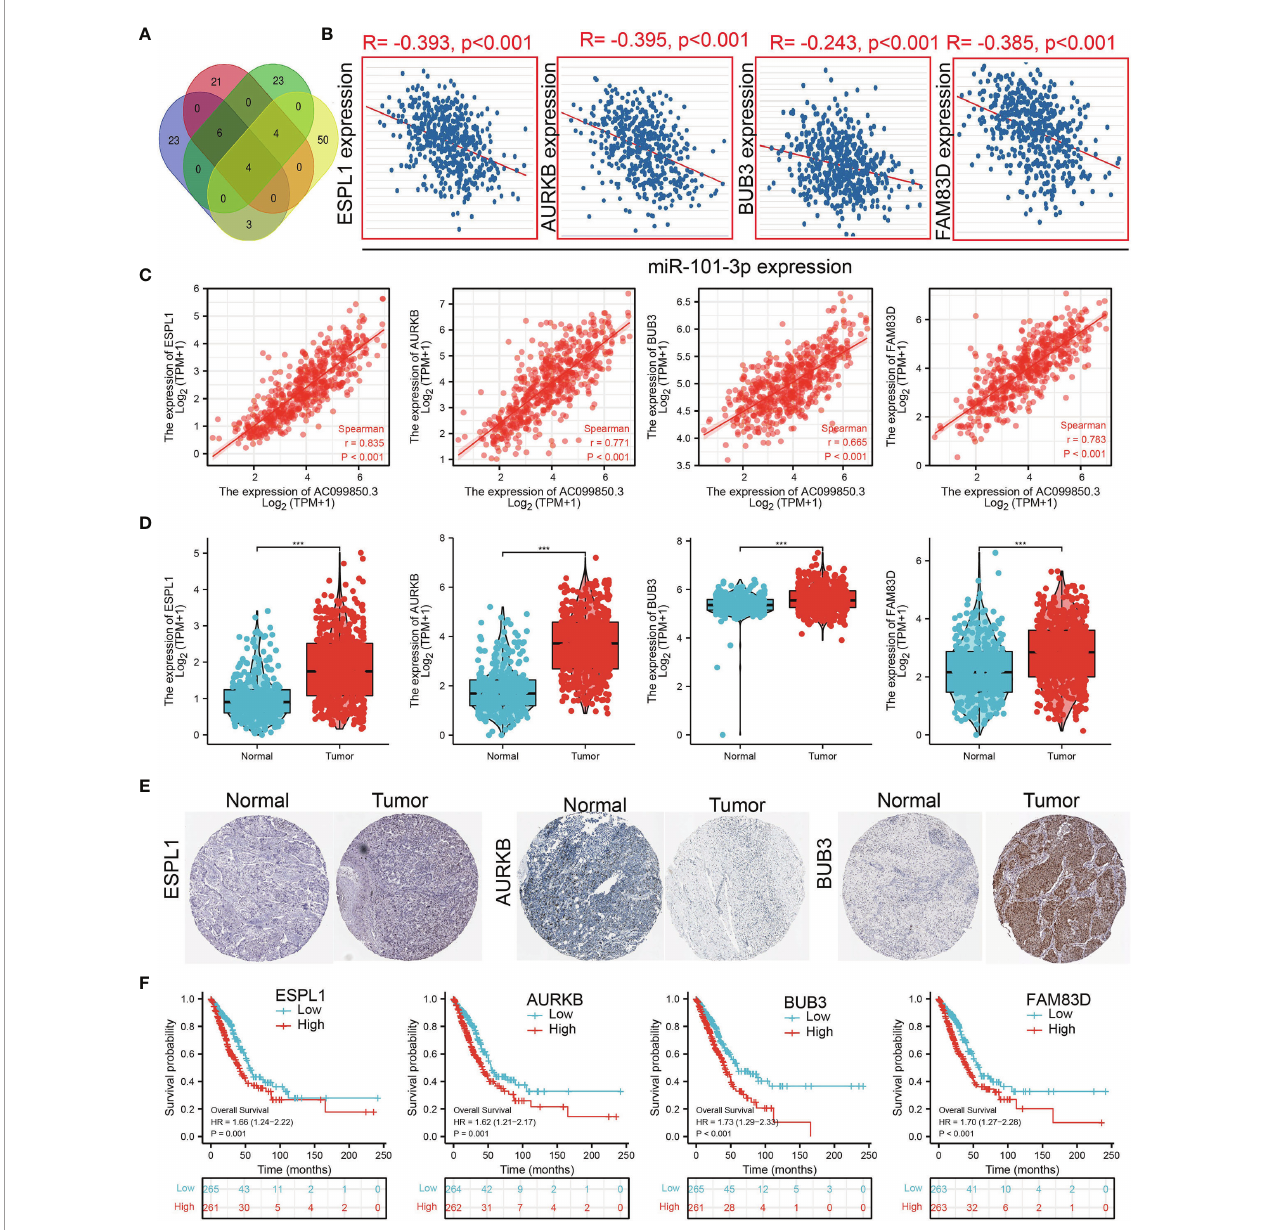
FIGURE 9 | Analysis of the potential mRNAs of AC099850.3/miR-101-3p. (A) Identifying ESPL1, AURKB, BUB3, and FAM83D as the downstream target of miRNA- 101-3p using various datasets. (B) Correlations between miRNA-101-3p expression and ESPL1, AURKB, BUB3, and FAM83D in LUAD. (C) Correlations between AC099850.3 expression and ESPL1, AURKB, BUB3, and FAM83D in LUAD. (D, E) The RNA and protein level of ESPL1, AURKB, BUB3, and FAM83D in LUAD. (F) The overall survival of GALNT3, CYCS, EIF5A, and ITGB4 in LUAD. ***P <